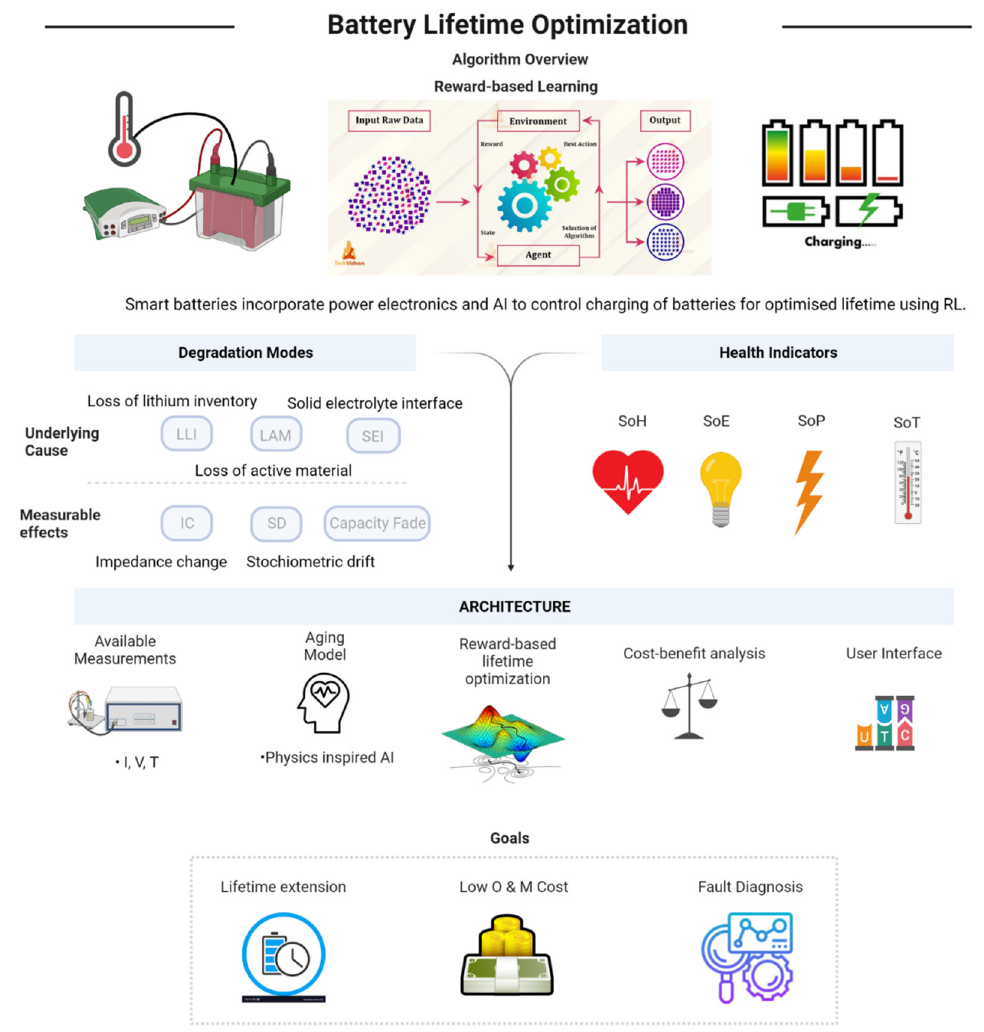
Figure 13. A flowchart of the BPO framework, showing the use of reward-based learning for optimizing the charging profile of Li-ion batteries by using measured V, I, and T. The brain of the system is physics-informed and maps degradation modesto quantifiable health indicators to achieve an extended lifetime of batteries along with added features of fault diagnosis and cost minimization.